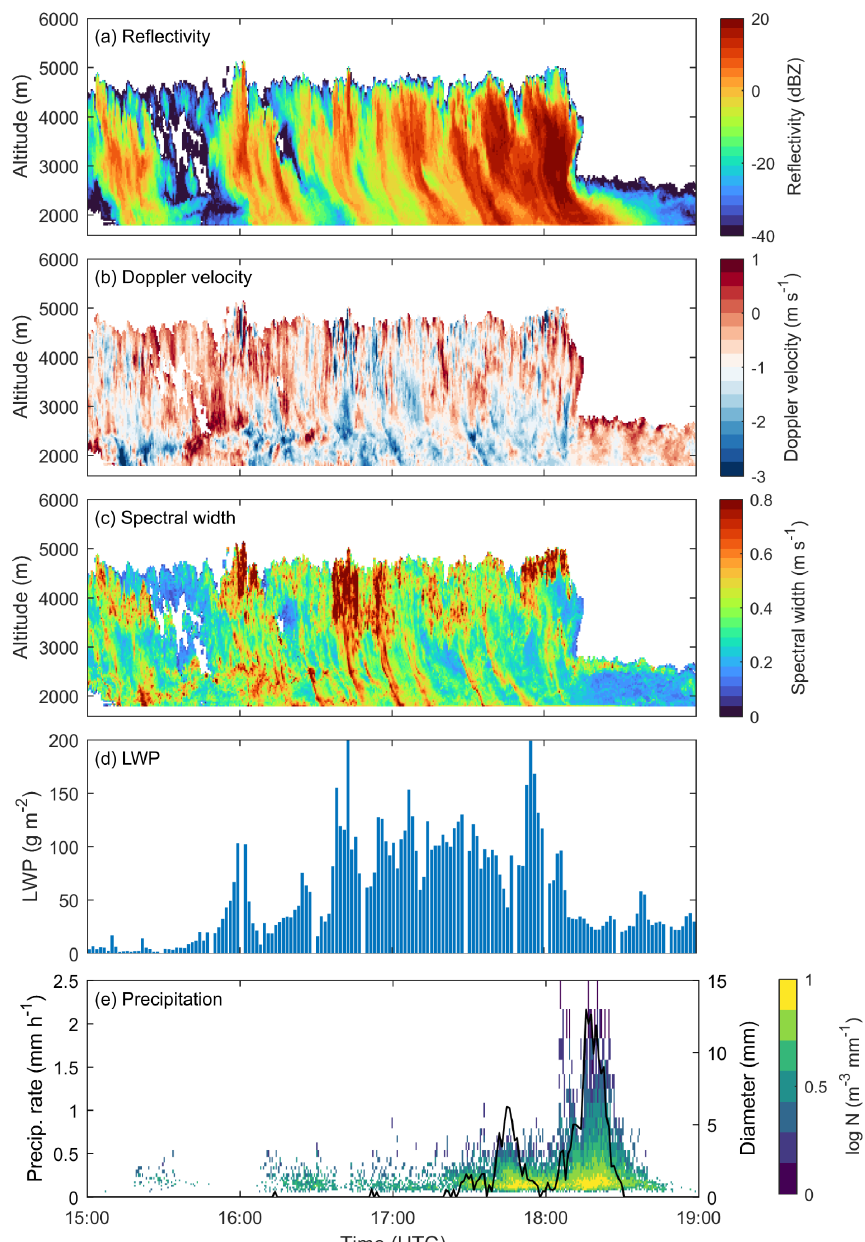
Figure 4. Observations of the cloud structure measured by the cloud radar (a–c) and the microwave radiometer (d) at Wolfgang on 8 March 2019. The cloud radar observations show the radar reflectivity (a) , Doppler velocity (b) and spectral width (c) . Note that the color bar in (b) is centered at − 1ms − 1 to approximately account for the hydrometeor fall speed. The column-integrated LWP measured by the microwave radiometer is shown in (d) , and the precipitation measured by the disdrometer at Wolfgang (1630m) is shown in panel (e)